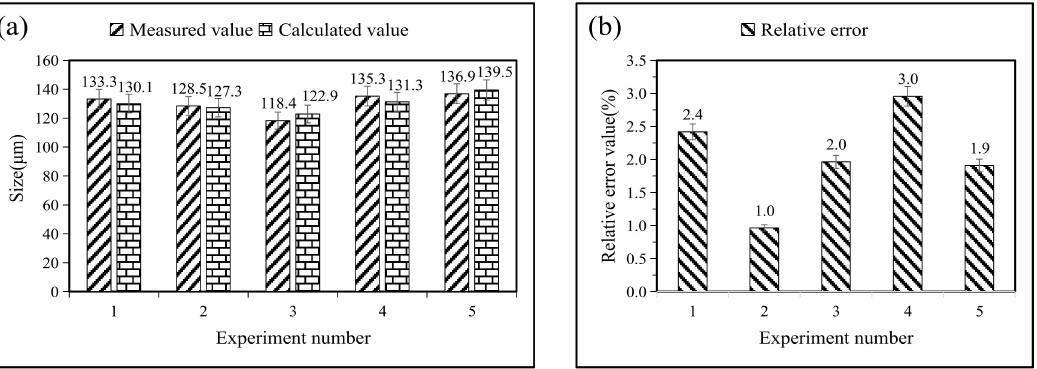
Figure 13. Error verification of Equation (9) (( a ). comparison of measureed value and calculated value; ( b ). corresponding relative error).